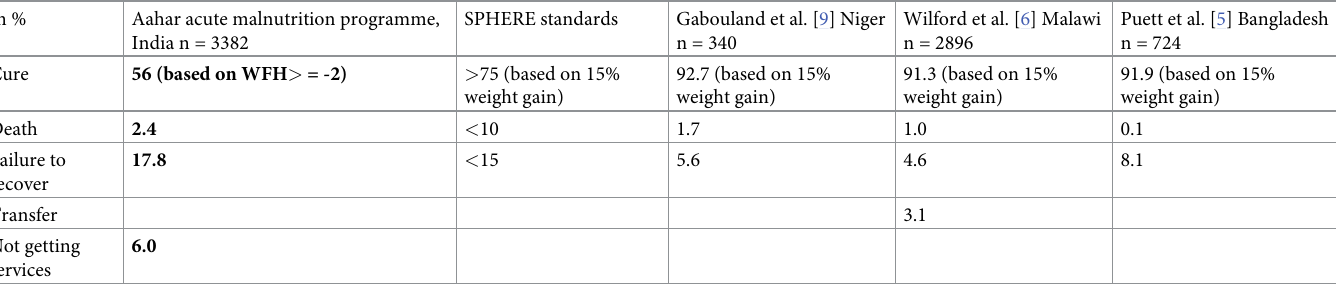
Table 4. Performance indicators comparison of Aahar acute malnutrition programme with SPHERE and other CEA studies of nutrition interventions. In